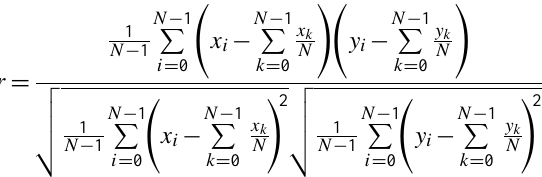
Fig. 2. An example of magnetosheath magnetic field strength mea- surements made by all Cluster spacecraft on 12 December 2002 and the way of data selection. Two shadowed intervals denote those in- tervals that were excluded from data